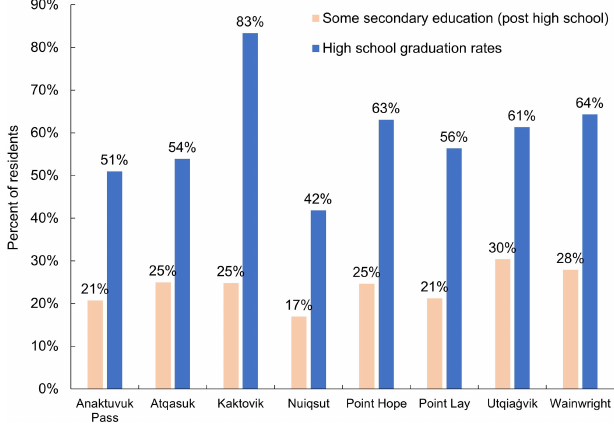
Fig. 5 . Percentage of residents 25 and older with education TableID: